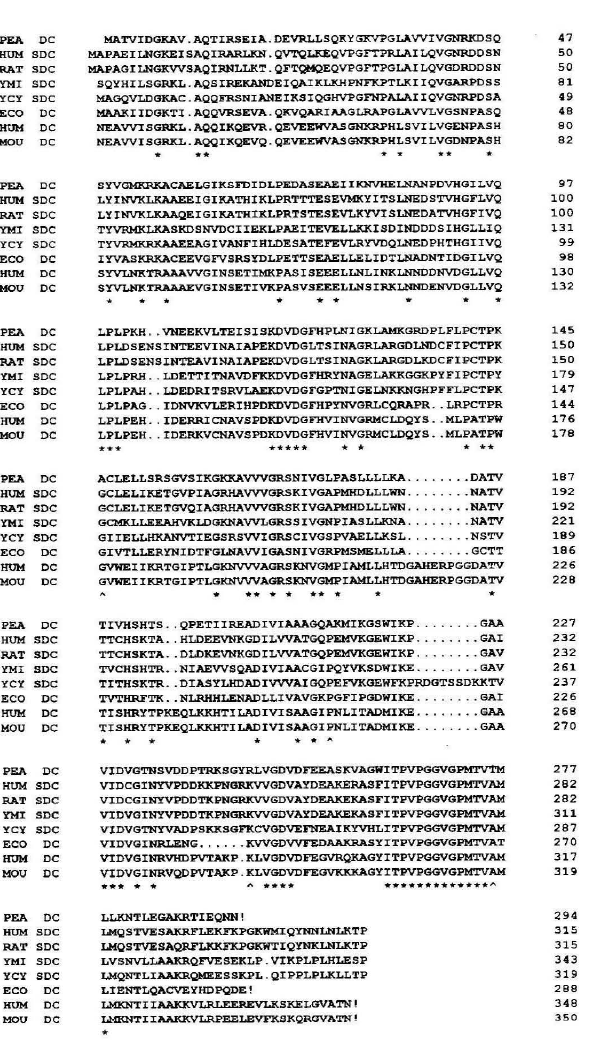
Figure 2. A comparison of the deduced amino acid sequences of eight different proteins exhibiting folate-dependent de hydrogenase and cyc1ohydrolase actvities. Protein sources are: HUM, human; YMI, yeast mitochondria; YCY, yeast cytoplasm; ECO, E. coli; and MOU, mouse. Enzyme activities are: S, Formyltetrahydrofolate synthetase; D, Methylenete trahydrofolate dehydrogenase; C, Methenyltetrahydrofolate cyclohydrolase. Stop co dons are indicated by (!). Numerals indicate amino acid positions as reported in the data bank. Amino acids common to all eight sequences are indicated by subscript asterisks. Amino acids present in all seven sequences but absent in the pea sequence are indicated by a subscript (1\